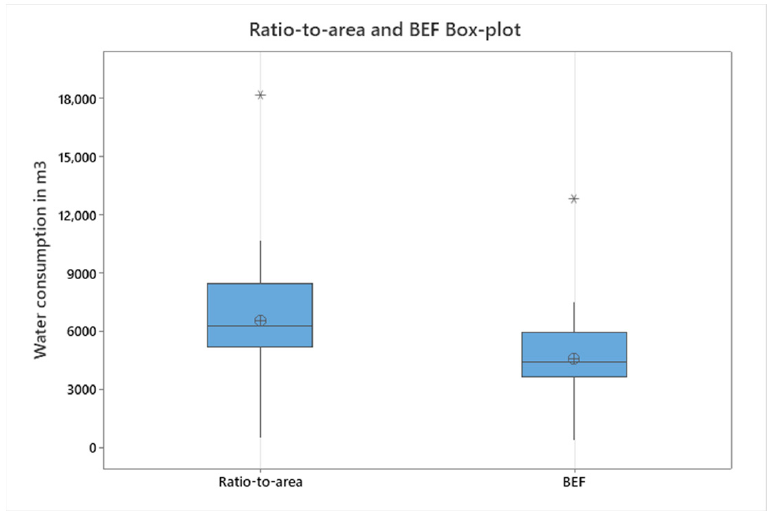
Figure 5. Ratio-to-area and BEF box-plot.